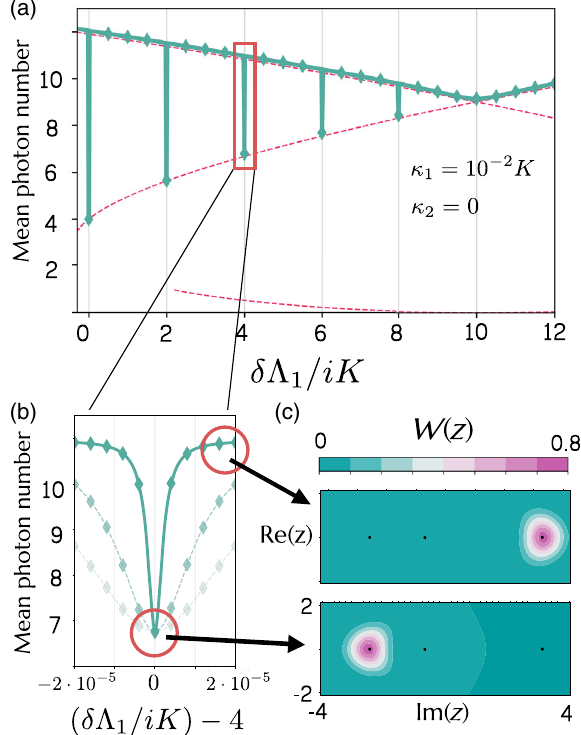
FIG. 4. Generalized photon blockade. (a) Mean steady-state cavity- a photon number as a function of the single-photon drive δ Λ ≡ Λ − Λ ð 0 Þ Λ ð 0 Þ 0 . 01 − 10 i Þ K is de- 1 1 1 , where the offset 1 ¼ ð termined from Eq. (47) and our choice of system parameters. The periodic, sharp drop in photon number corresponds to a gener- alized photon-blockade phenomenon, which occurs whenever the parameter r 1 [cf. Eq. (39)] is a non-negative integer. Solid lines: analytic exact solution. Diamonds: master equation numerics. Photon numbers associated with the semiclassical stationary stable amplitudes are also plotted (dashed red lines). (b) Enlarge- ment of one of the blockade antiresonances. Loss values are κ 100 , K= 20 , and K= 10 , with more faded green corre- 1 ¼ K= sponding to greater loss. (c) Steady-state Wigner function for two choices of δ Λ 1 corresponding to being either at (off) a blockaded parameter value; black dots indicate the three semiclassical amplitudes that exist for these parameters. For all results, Δ ¼ 5 K , Λ 4 K , κ 10 − 2 K , and Λ κ 0 . By using 2 ¼ 1 ¼ 3 ¼ 2 ¼ nonlinear coherent driving Λ 3 , this blockade phenomenon can be made sharp (i.e., there is a sharp cutoff in the photon-number